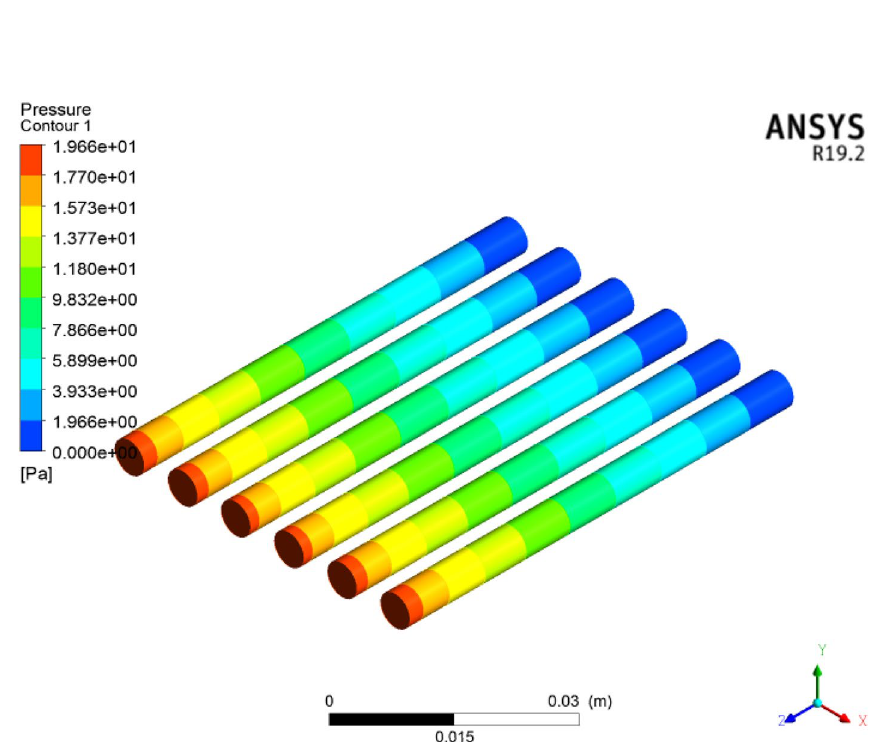
Figure 20. Contour of pressure in six circular